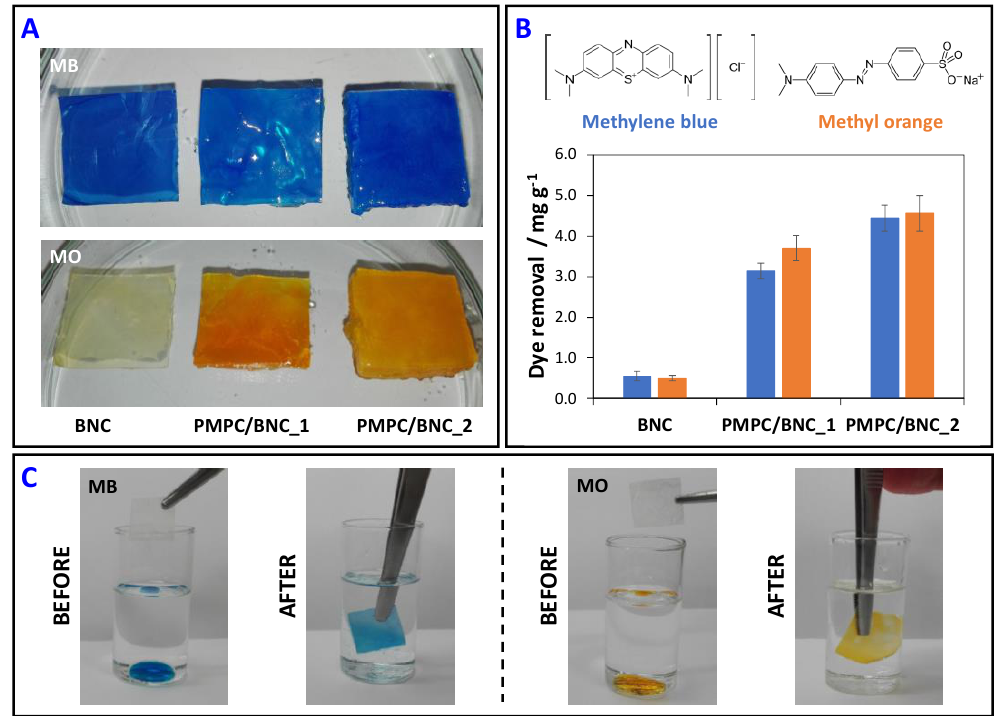
Figure 9. Photographs ( A ) and ( B ) dye removal capacity of BNC, PMPC/BNC_1 and PMPC/BNC_2 after 12 h of immersion in the dye aqueous solution, and ( C ) photographs of the MB and MO aqueous solutions removal from paraffin oil by PMPC/BNC_2 nanocomposite.